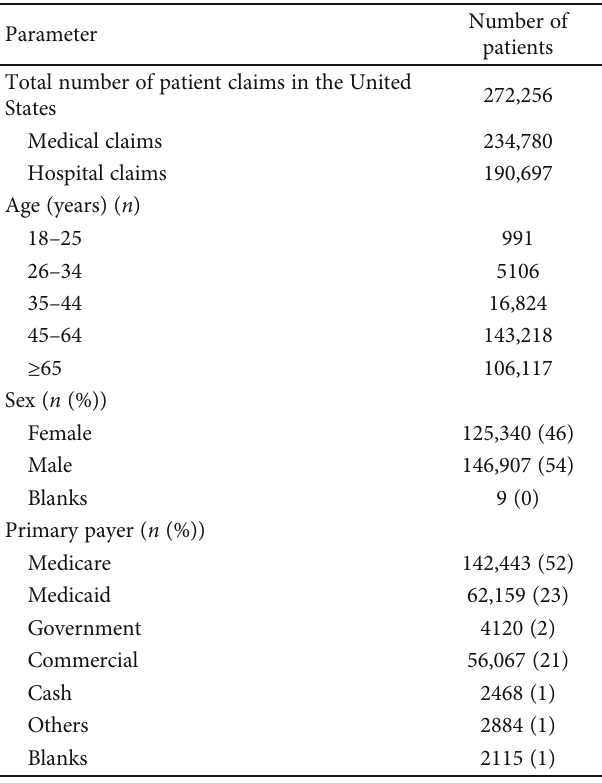
Table 2: Characteristics of patients with cirrhosis identi fi ed in the APLD claims